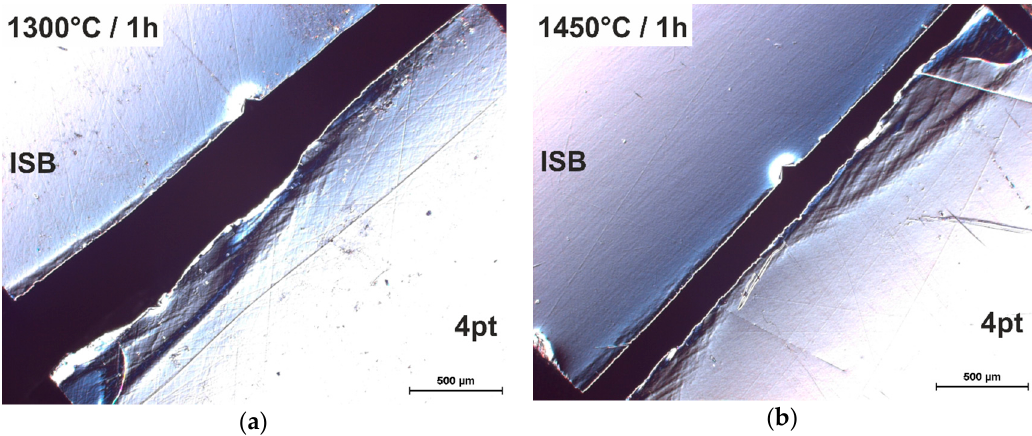
Figure 10. Transformation zones on the tensile side of TZP fractured by ISB test and four-point bending test, ( a ) sintered at 1300 °C/1 h, ( b ) sintered at 1450 °C/1 h.